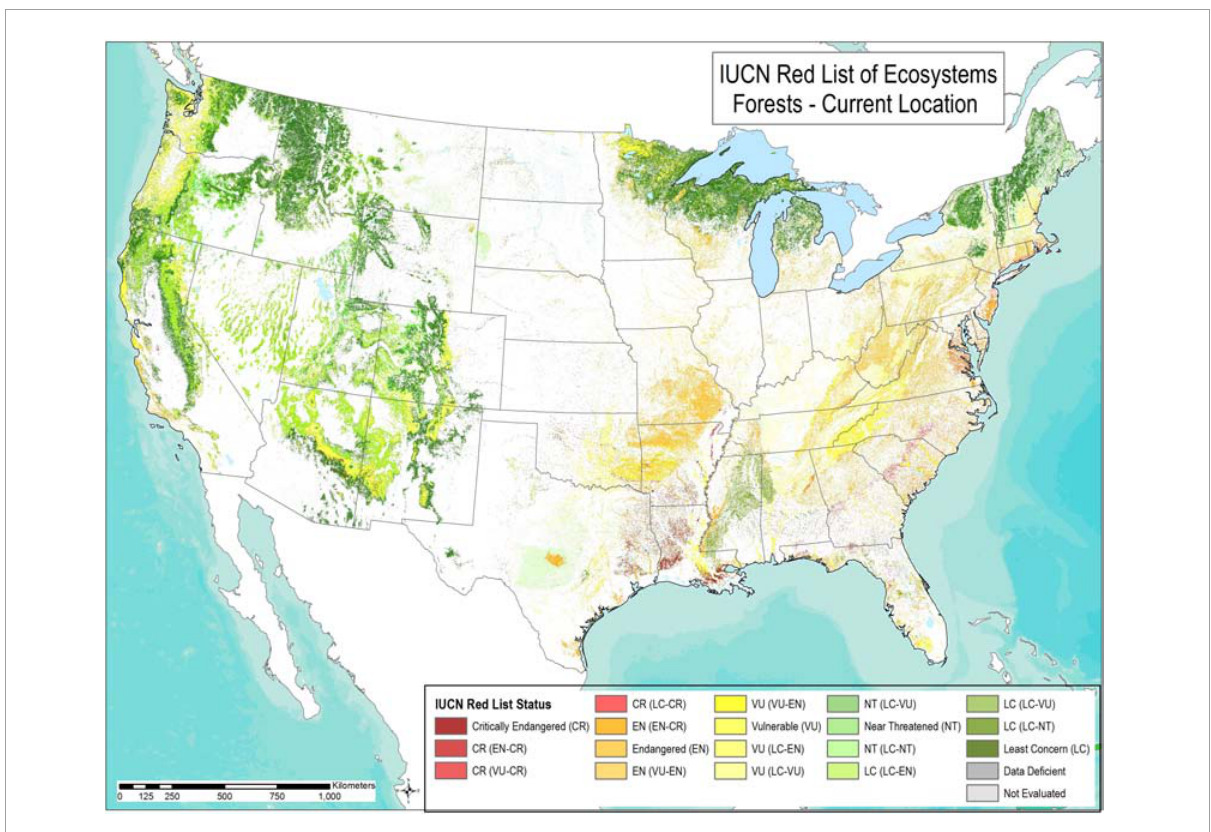
FIGURE6 Current distribution of 182 forest and woodland ecosystem type categories under the IUCN Red List of Ecosystems (Comer et al., 2022). Nearly all these distributions include mature and old-growth forests ( Supplementary Table 2 ).